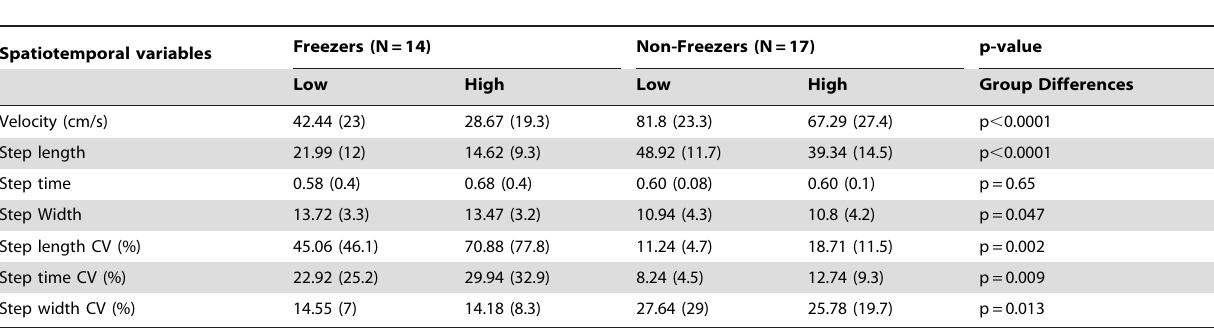
Table 3. Comparison of overall spatiotemporal aspects of gait between Freezers and Non-freezers.